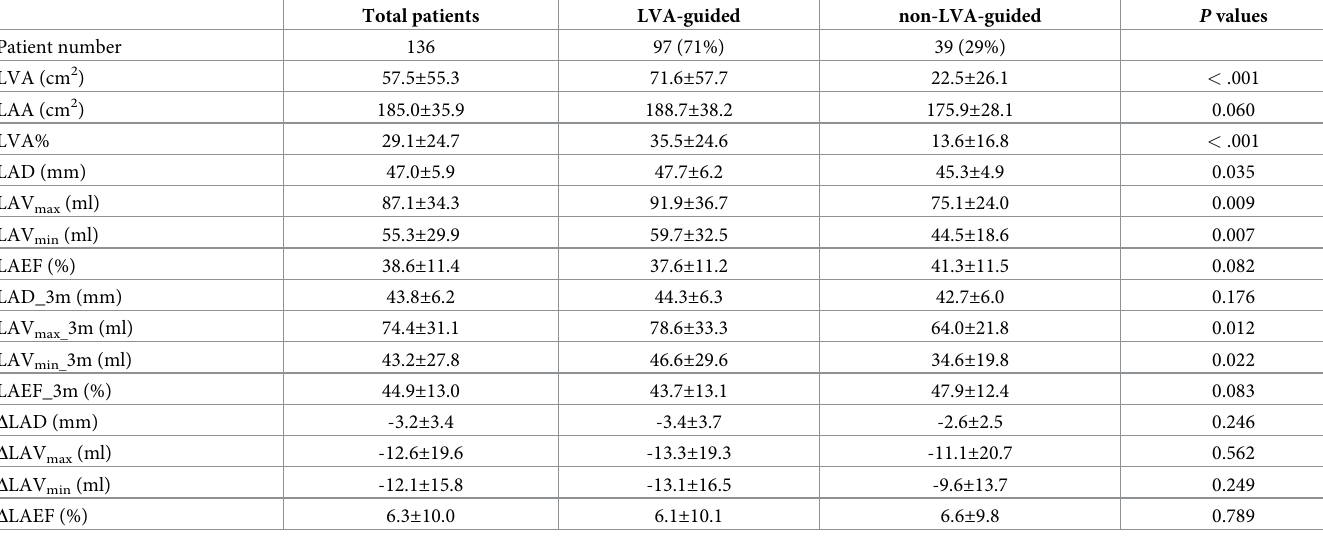
Table 6. Summarized results of left atrial characteristics in patients undergoing LVA- and non-LVA-guided left atrial linear ablation. Total patients